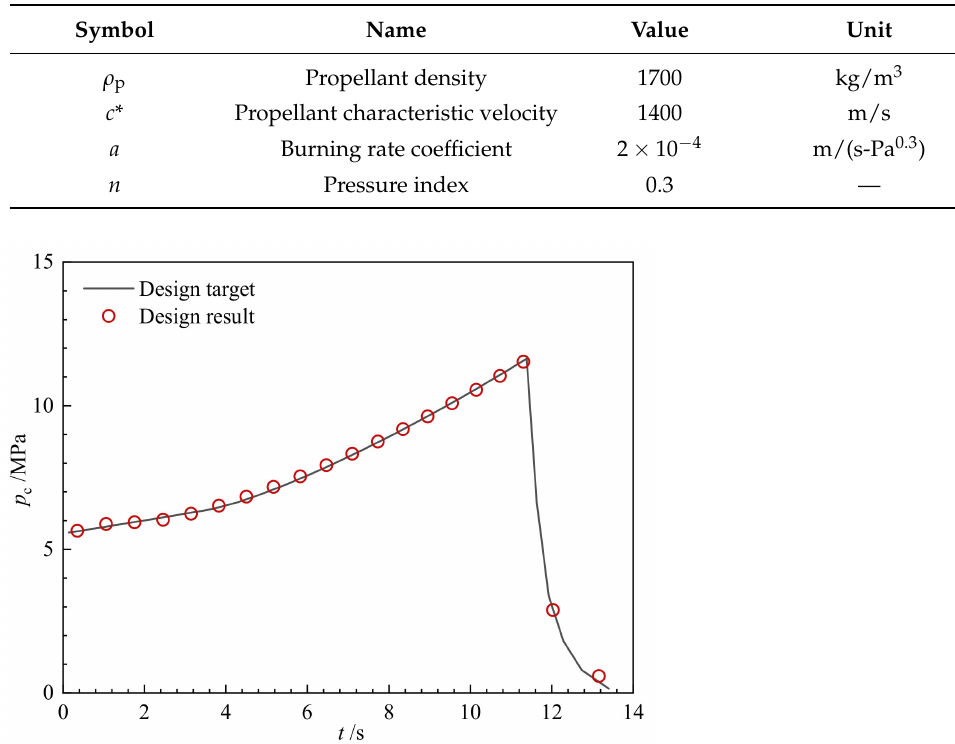
Table 4. Combustion characteristics of the star grain propellant.